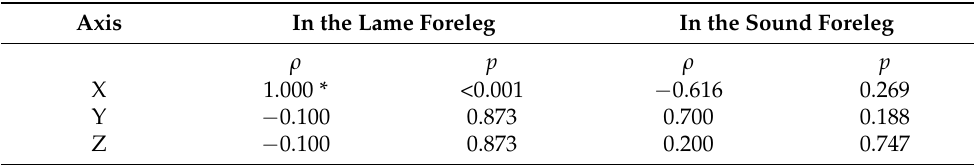
Table 6. Spearman’s rank correlation coefficients and their significance showing the relationship between the main value of impulses and lameness scores in the horses with a lame hind-leg ( n = 5). Axis In the Lame Hind-Leg In the Sound Hind-Leg ρ p ρ p X 1.000 * <0.001 0.308 0.614 Y 0.000 1.000 − 0.800 0.104 Z − 0.600 0.285 0.359